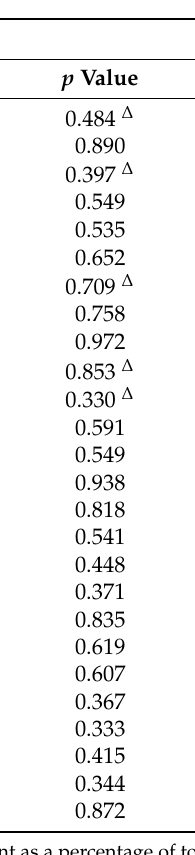
Table 2. Maternal dietary intakes of energy and nutrients between the control and supplement groups at the time of enrollment and the end of the